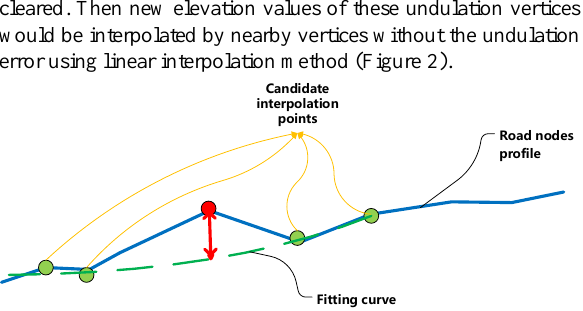
Figure 2. Diagram of the smoothing algorithm. The blue line is the road nodes profile, the green points is the candidate interpolation points, the green line is the fitting curve